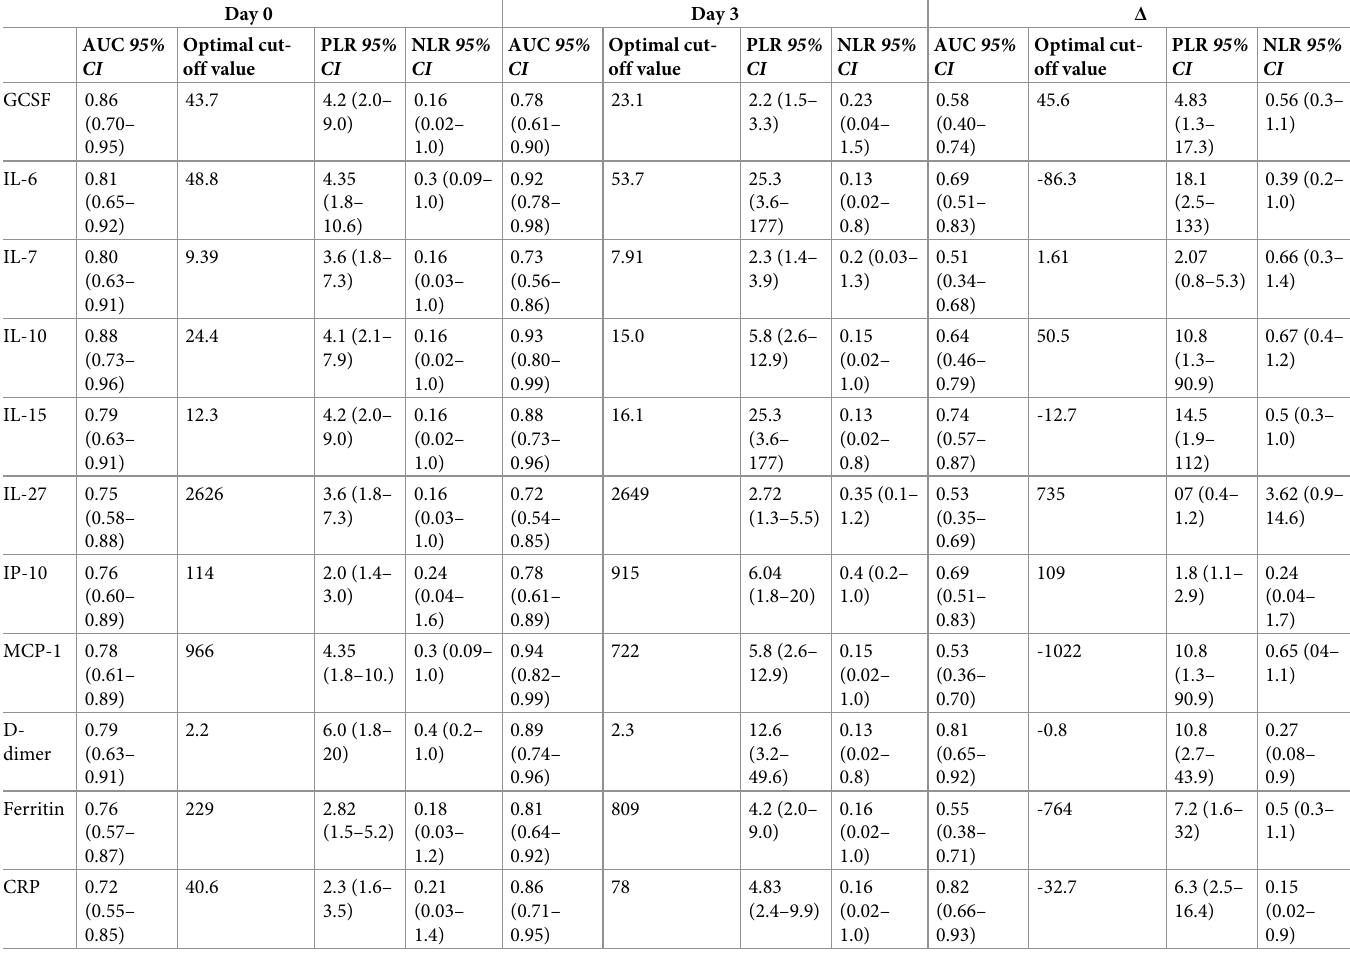
Table 3. Values of changes in cytokine and some biomarkers levels for prediction of mortality in COVID-19 cases.